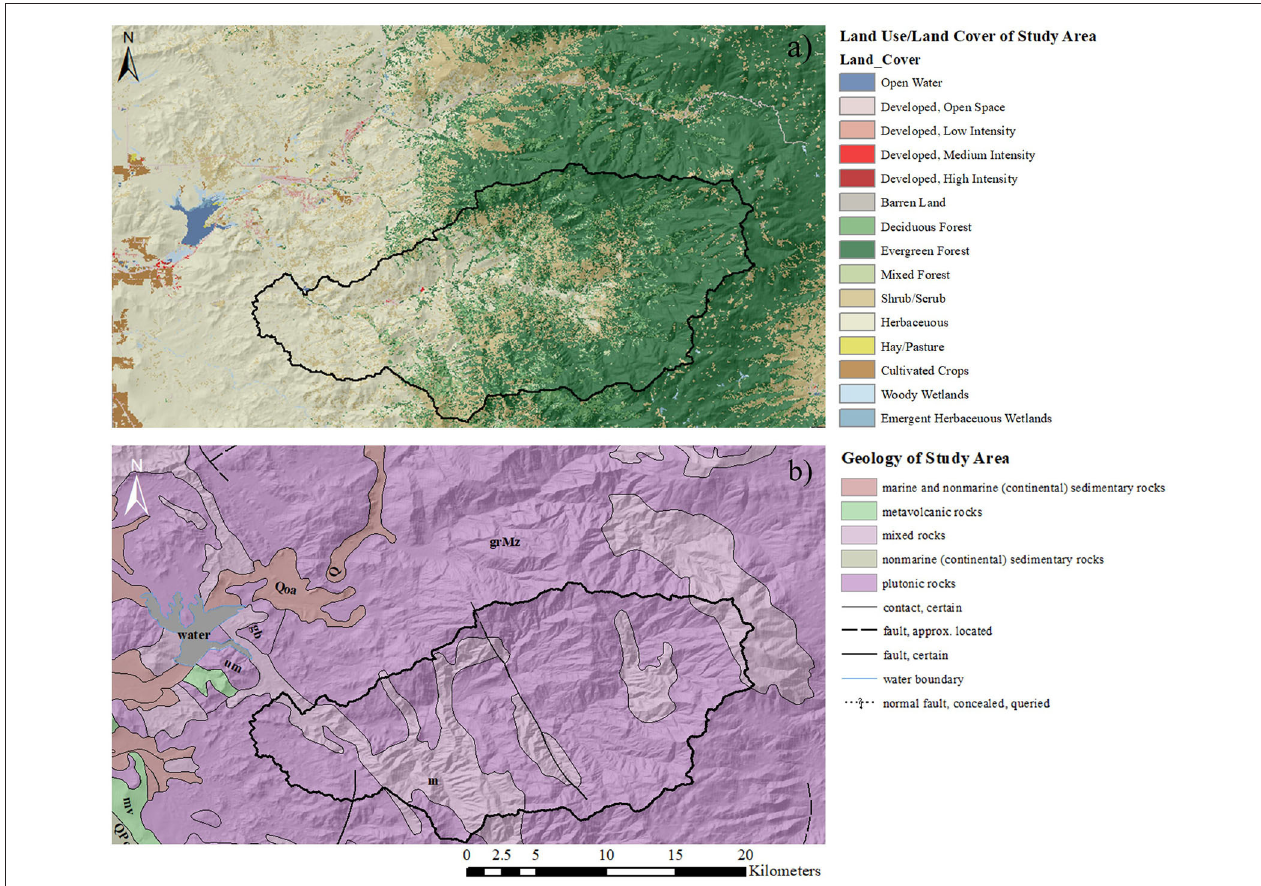
FIGURE 3 | (a) Multi-Resolution Land Characteristics Consortium (MRLC) (2018) land use/land cover classification input raster of model domain. (b) Surficial geology units and faults across model domain (USGS). Calibration watershed outlined in